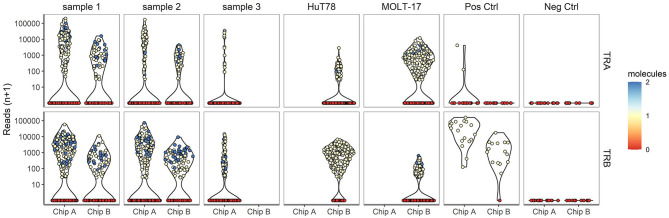
TRA/TRB clusters per single cell for different samples. The number reads for TRA (upper panel) and TRB (lower panel) clonotypes (depicted on the Y-axis) for each single cell plotted per sample for chip A and B (depicted on the X-axis).